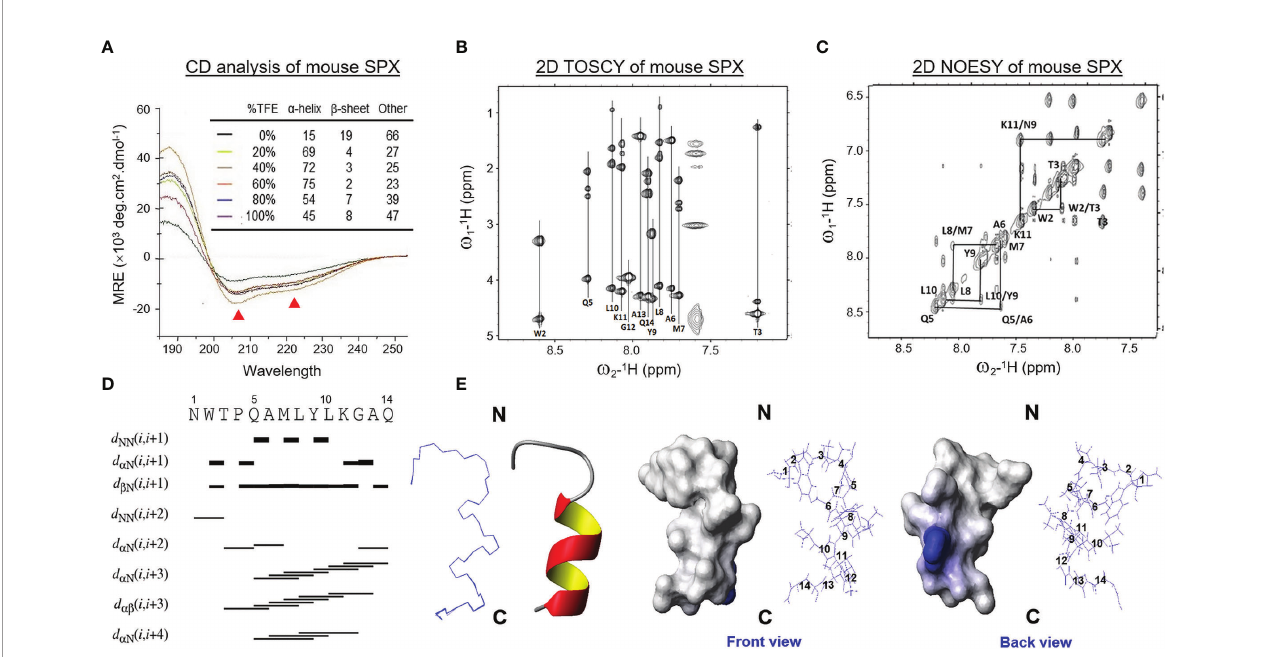
FIGURE 1 | Solution structure of mouse SPX. (A) Analysis of secondary structure elements in mouse SPX by CD spectroscopy. The CD spectra of mouse SPX (NWTPQAMLYLKGAQ) were obtained in a solvent system composed of distilled water with increasing levels of TFE (0 – 100%) and the relative contents of secondary structure elements were deduced by deconvolution analysis based on the readings of mean residue ellipticity (MRE). (Ellipticity minima at 208 and 222 nm indicative of helical structures were marked by red triangles.) Identi fi cation of spin systems for individual a.a. in mouse SPX and their through-bond/through-space correlations by TOCSY and NOESY experiments conducted in 60% d4-TFE at 298K. Data presented are the fi ngerprint region showing C a -N a H 1 H-NMR cross-peaks of 2D TOSCY (B) and NH-NH region with N a H i -N a H i+1 1 H-NMR cross-peaks of 2D NOSEY of mouse SPX (C) . (D) Delineation of helical region in mouse SPX by NOE connectivities deduced from TOCSY and NOESY spectra. Sequential dNN connectivities and assignments indicate the presence of an a helical structure from Gln 5 to Gln 14 in mouse SPX. (E) Stereoview superposition of fi nal restrained structures (in ribbon plot) and stereo model of mouse SPX (in surface plot). In the stereo model, both the front and back views are presented with basic a.a. in blue and neutral residues in white.